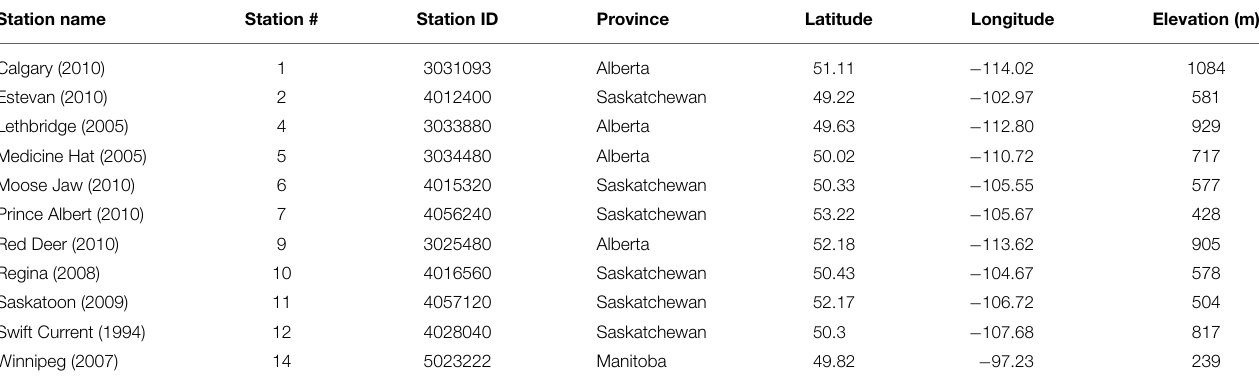
TABLE 1 | Climate stations: location and